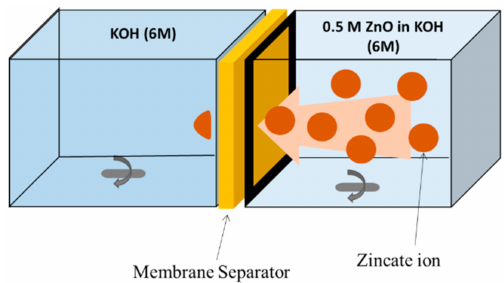
Figure 7. Schematic of the two-compartment cell used for measuring zincate crossover